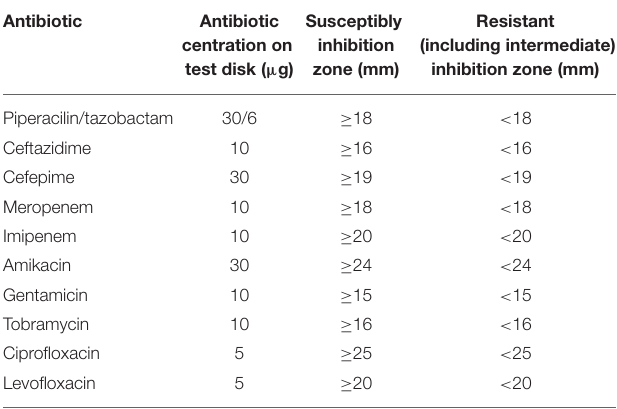
TABLE 2 | EUCAST Clinical Breakpoints for Pseudomonas spp.